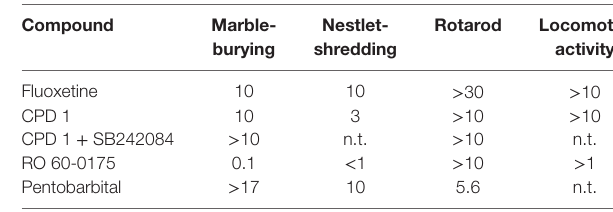
Values are minimal effective doses in milligrams per kilogram. The number of mice used/dose group were 12 (marble-burying), 8 (nestlet shredding), 12 (rotarod), and 12 for locomotor activity. n.t., not tested.